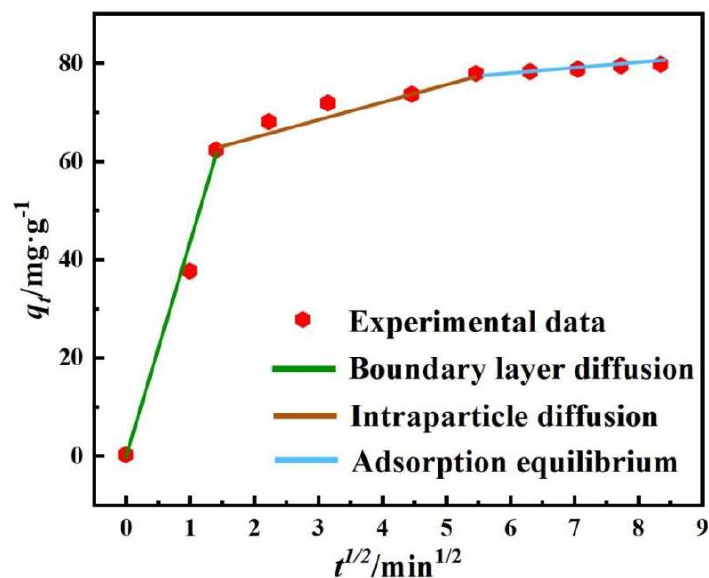
Figure 10. Diffusion model. Table 4. Diffusion model parameters.